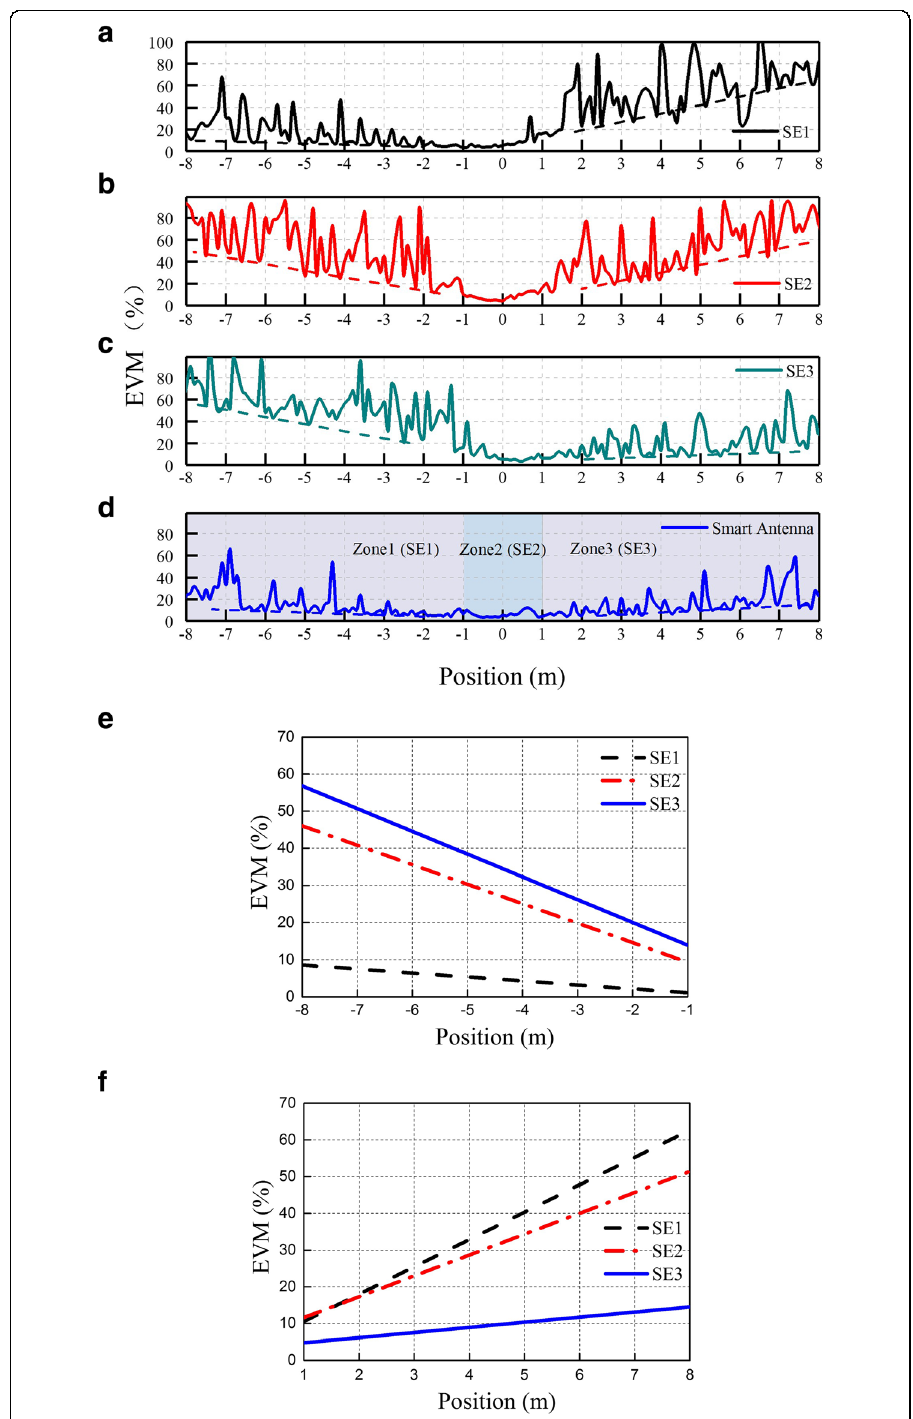
Fig. 17 (See legend on next